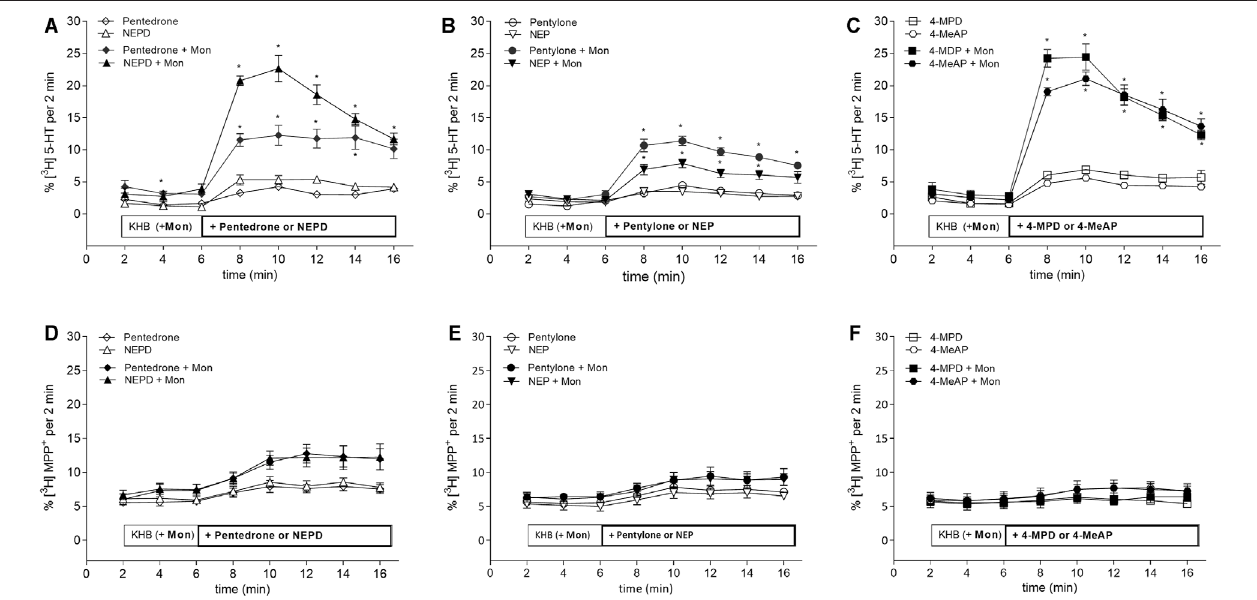
FIGURE3| Effectsofpentedrone, pentylone, 4-MPD,NEPD,NEP,and4-MeAPontransport-mediated releaseofpreloadedradiolabeledsubstratefrom HEK293 cells stably expressing the (A – C) SERT or (D – F) DAT. As indicated, after 6 min of basal release (in the presence of either KHB or KHB with monensin (Mon) 10 µM), the compound of interest was added at a concentration close to its predetermined IC 50 value for each transporter (SERT: pentedrone and NEPD (130 µM), pentylone (20 µM), NEP (6 µM), 4-MPD (30 µM), and 4-MeAP (10 µM); DAT: pentedrone and pentylone (0.5 µM), NEPD (0.2 µM), NEP and 4-Me-AP (0.1 µM), and 4-MPD (1 µM)). Synthetic cathinones were grouped in pairs according to the presence of a methyl or ethyl group at the amino terminal (pentedrone and NEPD; pentylone and NEP; 4-MPD and 4-MeAP). * denotes p < 0.05.